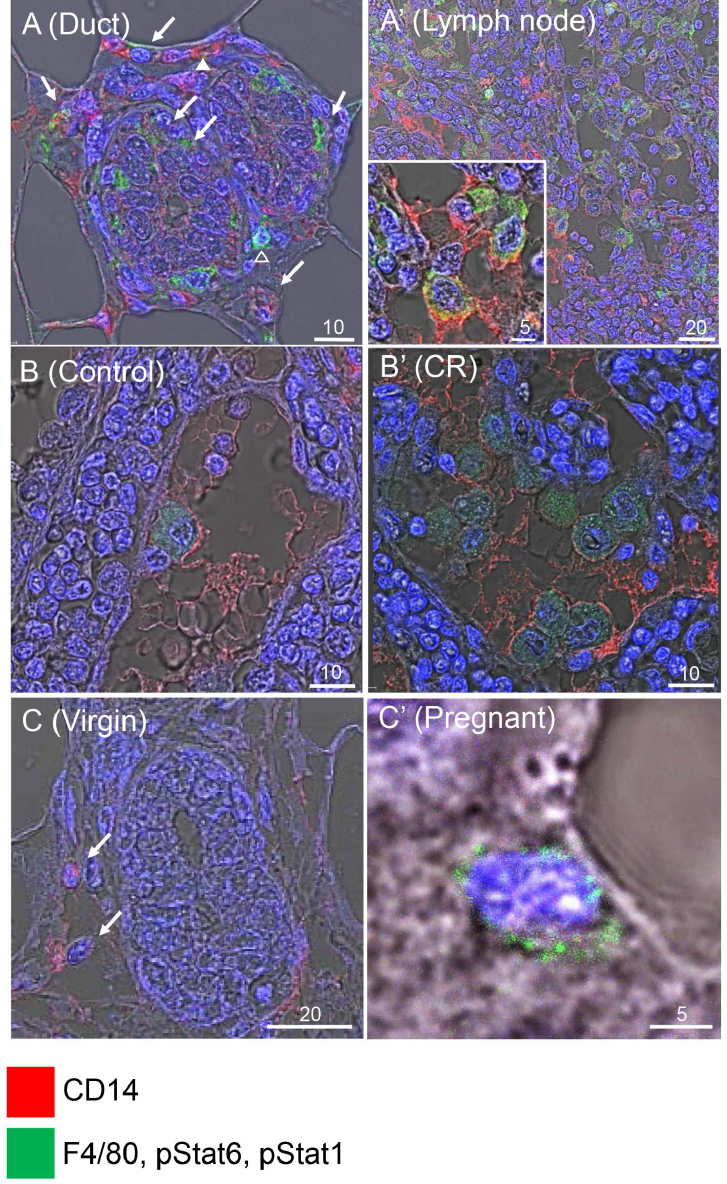
Figure 7. M2 macrophage polarization is induced by calorie restriction (CR). ( A , A’ ) CD14 and F4/80 are co-expressed in mammary ducts ( A ) and lymph node ( A’ ). Arrows indicate cells expressing both CD14 and F4/80. Arrowheads mark rare cells expressing either CD14 or F4/80. Inset, larger magnification of cells co-expressing CD14 and F4/80. ( B , B’ ) CR induces the number of cells co-expressing CD14 and pStat6. ( C , C’ ). The pStat1 expression is not detected in the virgin mammary gland by immunofluorescence, but pStat1-expressing cells are detected in the pregnant gland. Representative analysis of five independent mammary glands. Arrows indicate cells expressing CD14. Numbers above bars indicate their range in μM.